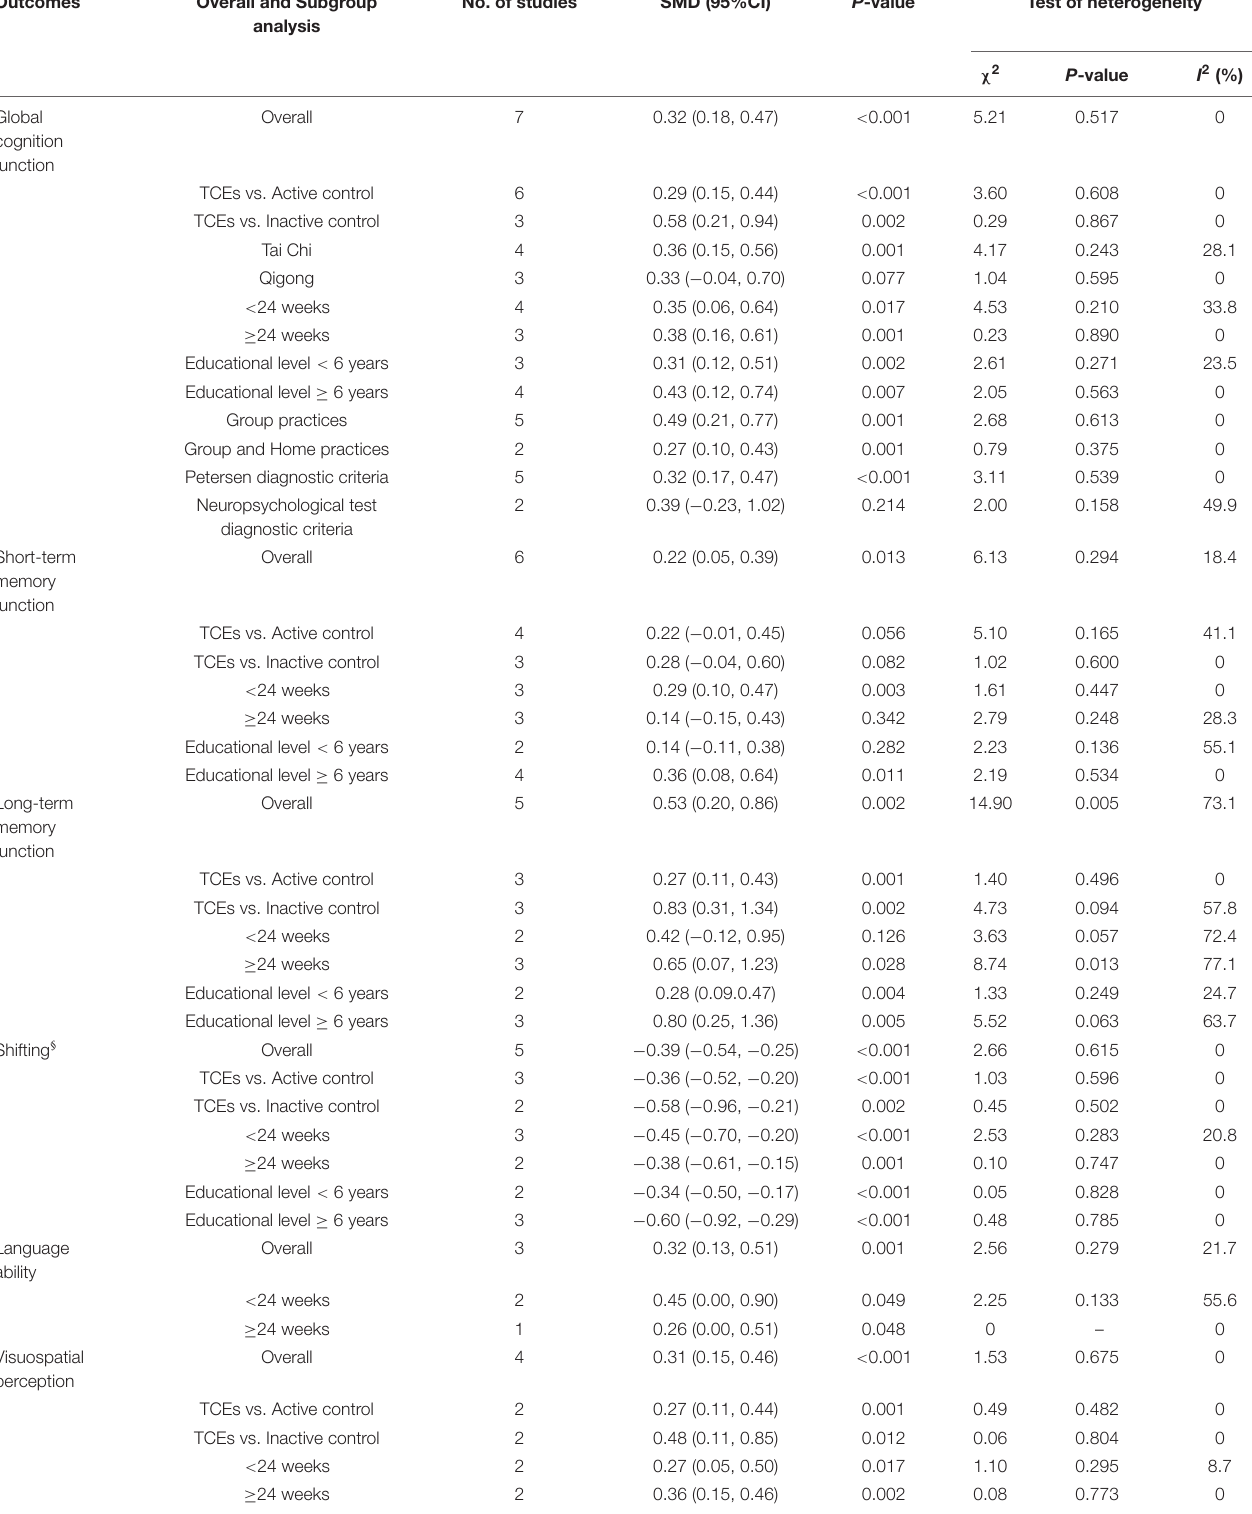
TABLE 3 | Overall and subgroup analysis results regarding the effects of Traditional Chinese Exercises on cognition function.